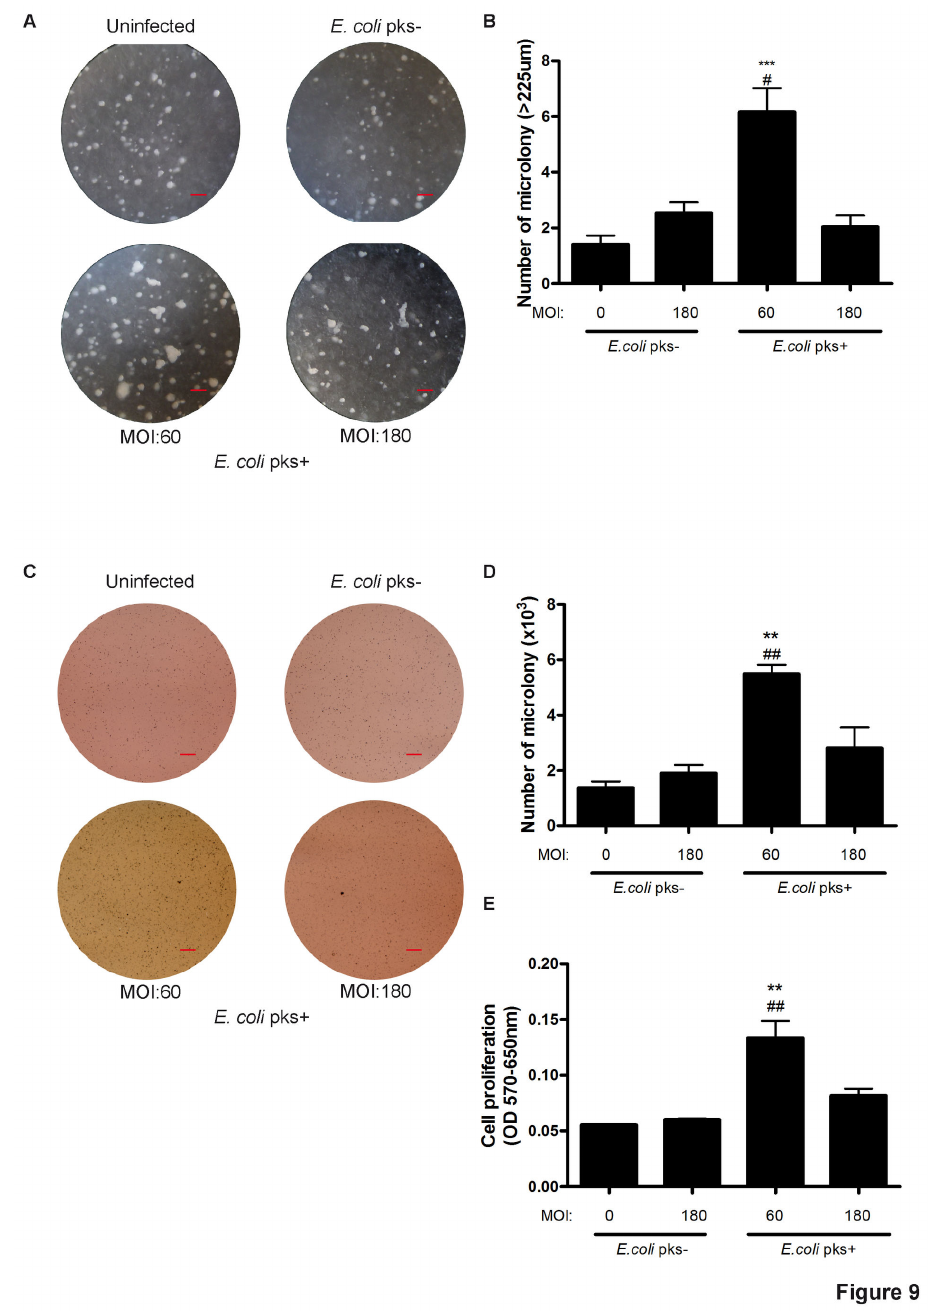
Figure 9. Senescent pks+ E. coli infected IMR-90 cells promote the growth of bystander tumour cells. IMR-90 cells were infected for 4h with live pks + or pks - E . coli with an MOI of 60 or 180 or left uninfected. At the end of the infection, the cells were washed and grown with gentamicin for 3 days. Then the IMR-90 cells were layered with 0.5% agar and 5000 HCT116 p53 -/- cells embedded in 0.35% agar were added on top of the first layer and co-cultured for 10 days. (A) Representative photomicrographs of HCT116 p53 -/- cell colonies, scale bars = 0.7 mm. (B) Large (>225 µm) microcolonies per microscopy field were counted by a blinded observer. The upper HCT116 p53 -/- cell layer was harvested and stained with MTT for 24h. (C) Representative photomicrograph of experimental 6-well culture plates with viable cancer cell colonies coloured by MTT, scale bars = 3 mm. (D) The number of microcolonies was quantified using Image-J. (E) Total cell proliferation was assessed using MTT. Results represent the mean and SEM of two independent experiments, one-way ANOVA with Bonferroni’s multiple comparison test; *P<0.05 comparing infected and uninfected groups; #P<0.05 comparing pks + and pks - groups. doi: 10.1371/journal.pone.0077157.g009 PLOS ONE |